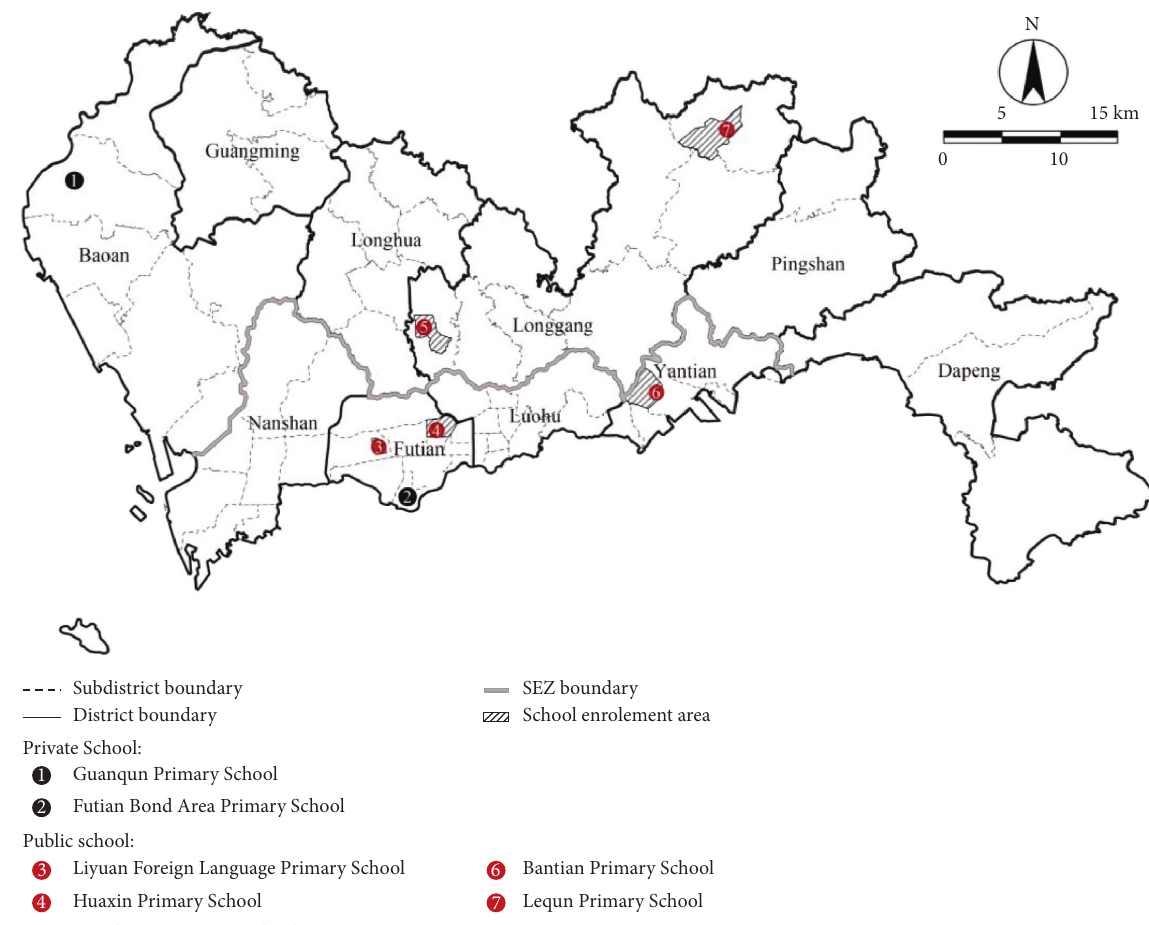
Figure 2: The geographical location of school samples.